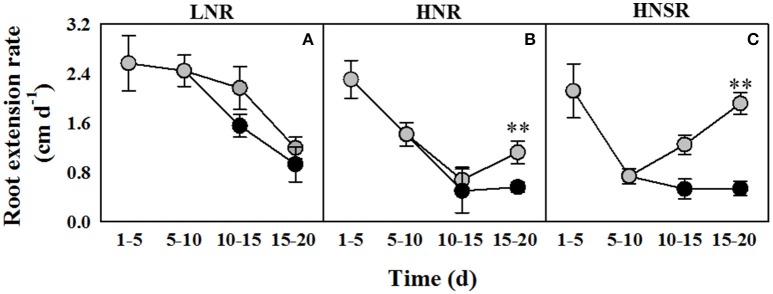
Root extension rate of durum wheat roots cultured in 0.1 (LNR, A) and 10 mM KNO3− with (HNR, B) or without (HNSR, C) split root system, under control () or salt (100 mM NaCl, ) conditions. Six replicate plants of each treatment were measured on days 5, 10, 15, and 20 of hydroponic culture. KNO3− was added on day 5 and 100 mM NaCl was added from day 10. The values are means ± SD (n = 6). Significant differences between treatments are indicated by asterisks (**p < 0.01; LSD-test).